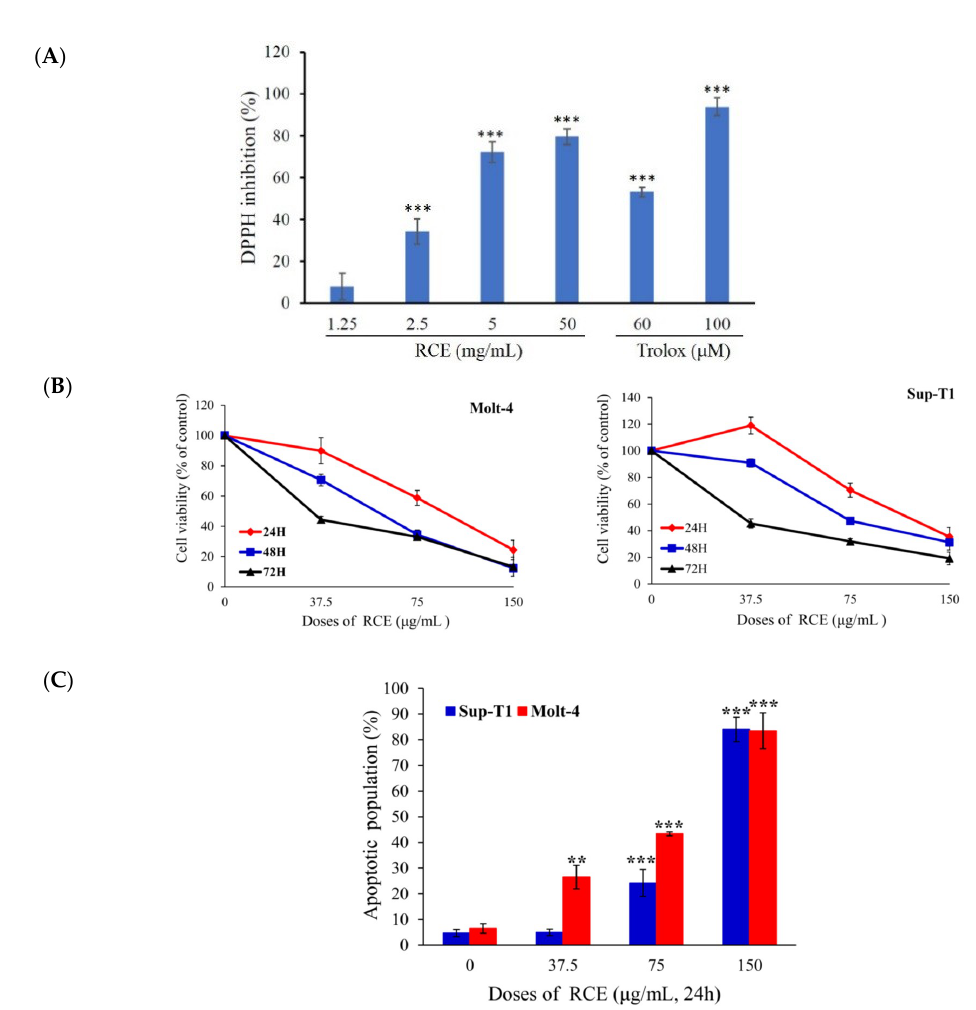
Figure 1. Effect of extract of Rosa cymosa (RCE) on cellular viability and apoptosis induction in the in vitro assay. ( A ) The anti-oxidative activity was determined by DPPH assay and Trolox served as the positive control; ( B ) Human leukemia Molt-4 and Sup-T1 cells were treated with RCE at different doses for 24, 48, and 72 h. Cell variability was determined by the MTT assay; ( C ) The apoptotic populations of Sup-T1 and Molt-4 cells were determined with flow cytometric analysis after treatment with RCE. Data are expressed as mean ± SD. * p < 0.05; ** p < 0.01; and *** p < 0.001 control vs. RCE group. The IC 50 value was calculated using CalcuSyn software.